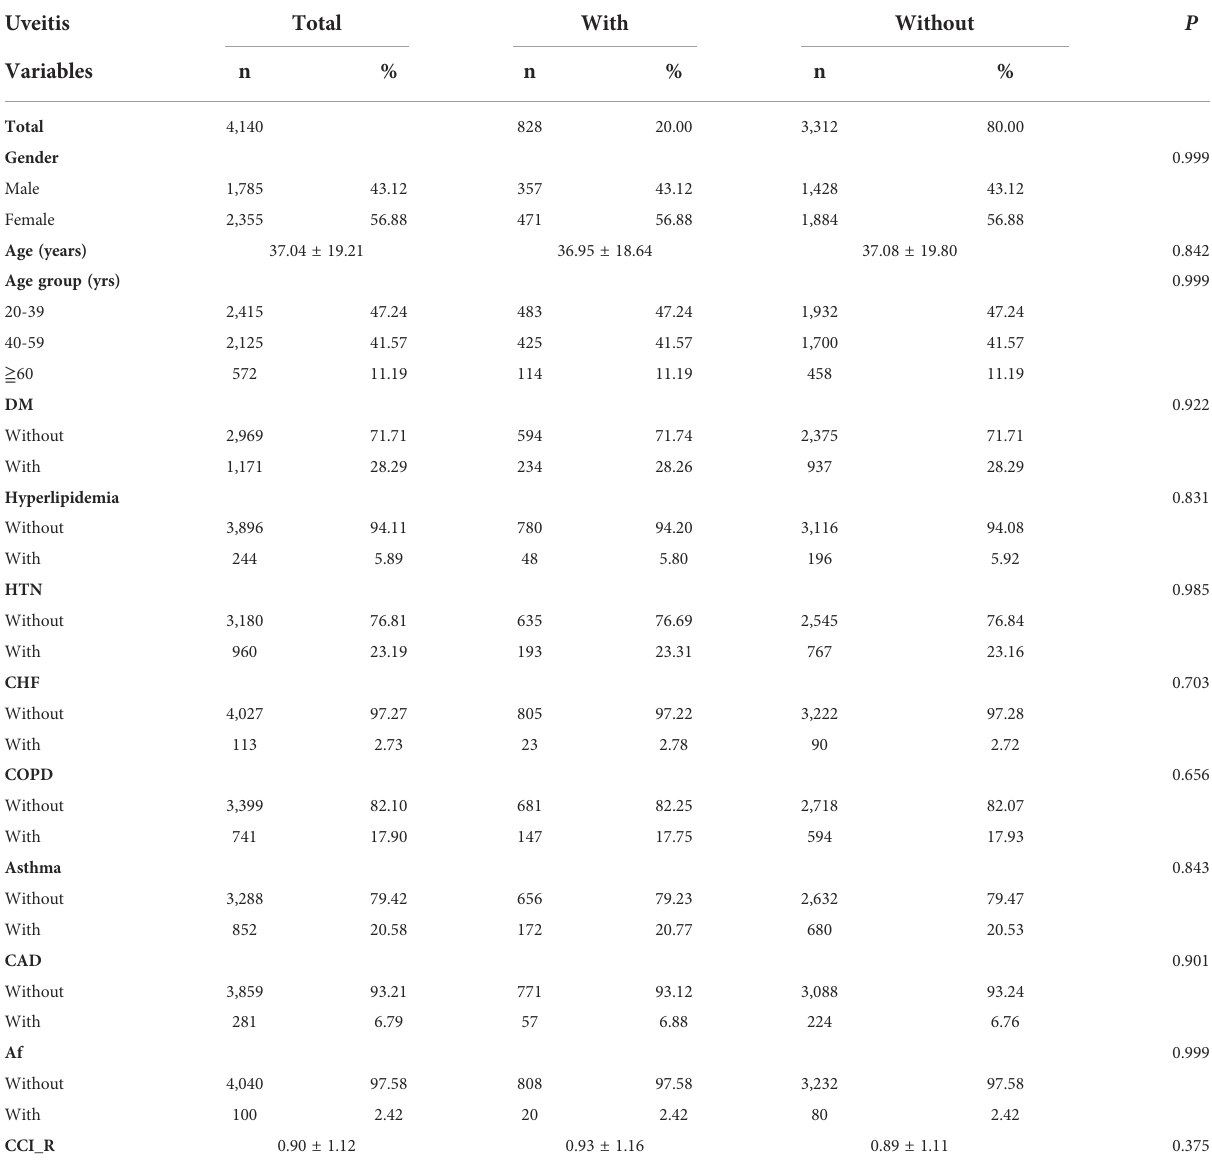
TABLE 1 Baseline characteristics of the enrolled patients. Uveitis Total